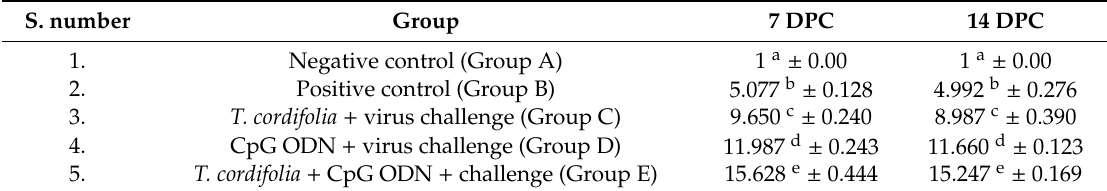
Table 6. Quantitative real time PCR analysis of IL-1 β expression in PBMCs of chickens challenged with vvIBDV at di ff erent